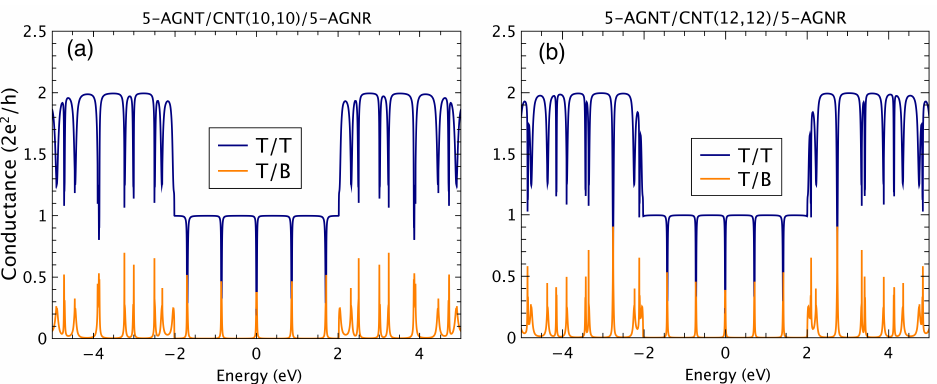
Figure 3. (Color online) Conductance results for the 5-AGNR/(n,n) CNT/5-AGNR, with n = 10 ( a ) and 12 ( b ) for T/T and T/B transport.